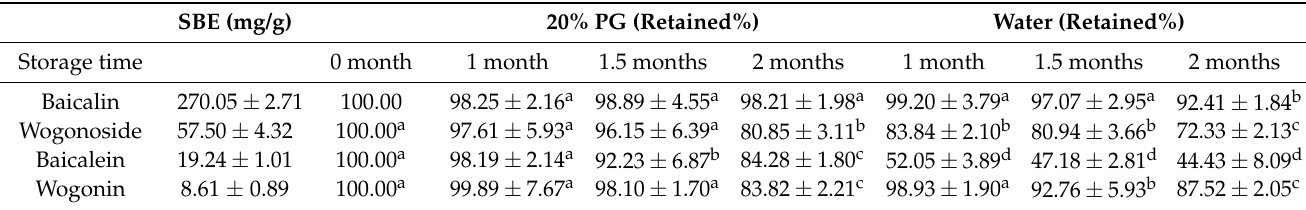
Table 1. The ingredient retained % of SBE storage for different months in 20% PG and